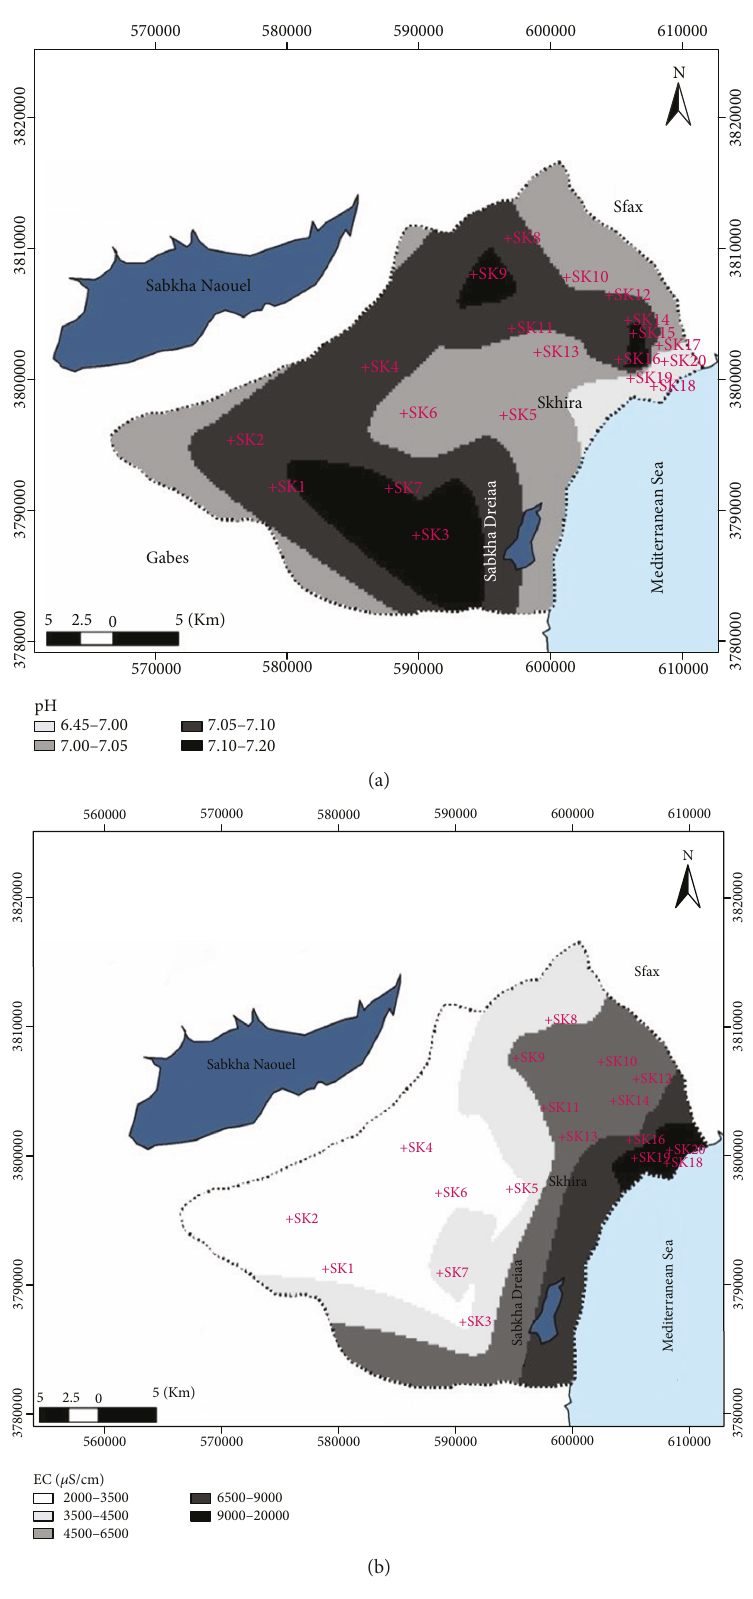
Figure 3: Spatial distribution maps of pH (a) and electrical conductivity (b) in groundwaters of the Skhira aquifer. See mean error (ME) and root mean square error (RMSE) in Table